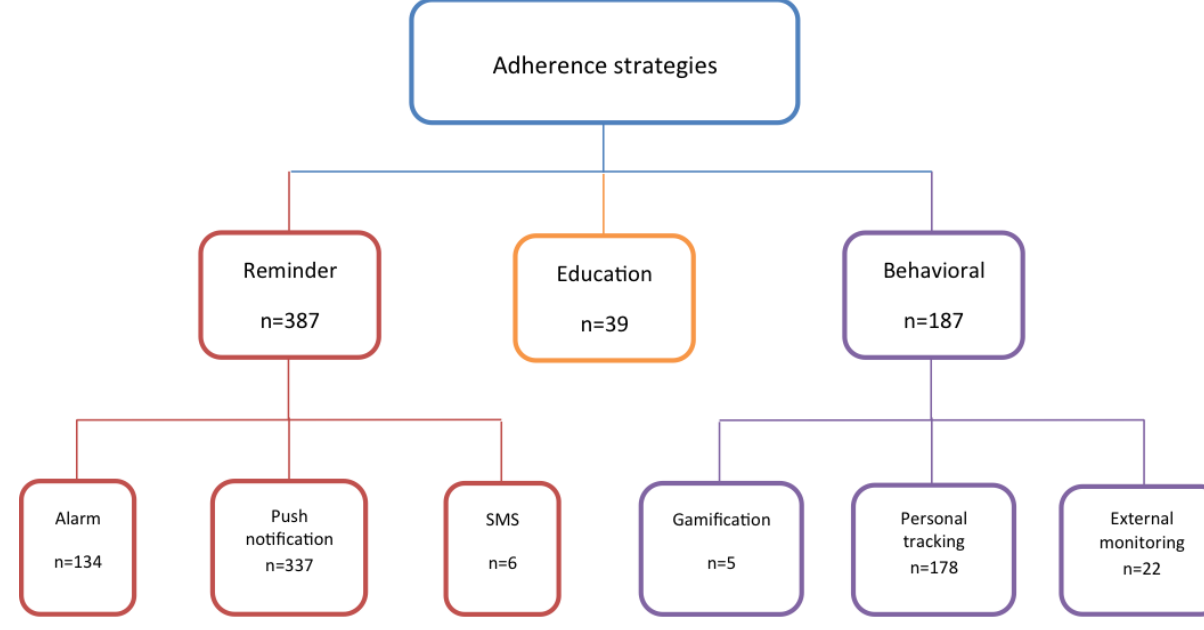
Figure 2. Taxonomy of identified adherence strategies.